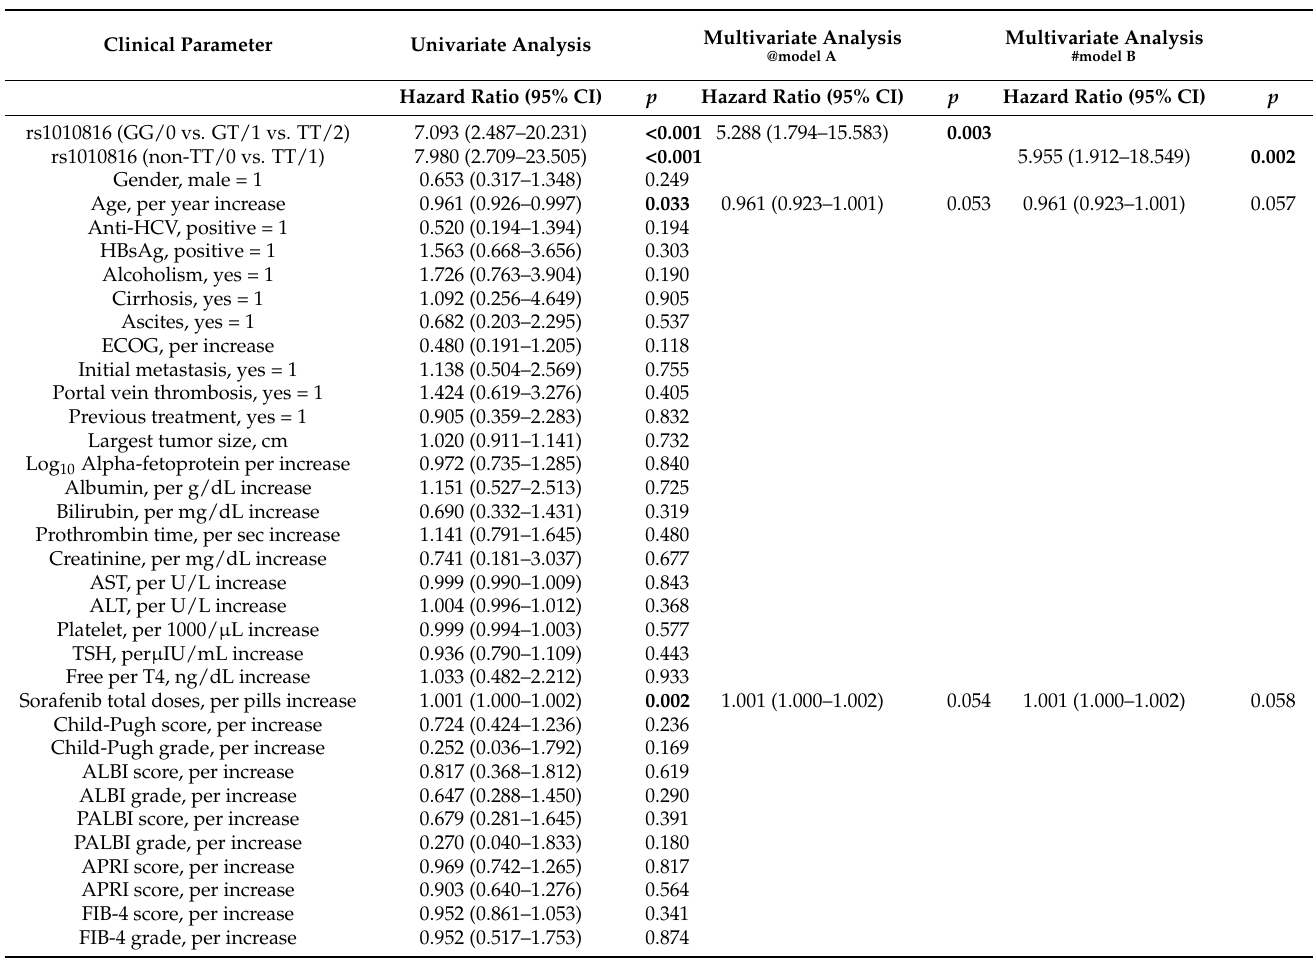
Table 2. Cox proportional hazard analysis for association between genetic and clinical factors and the sorafenib therapeutic